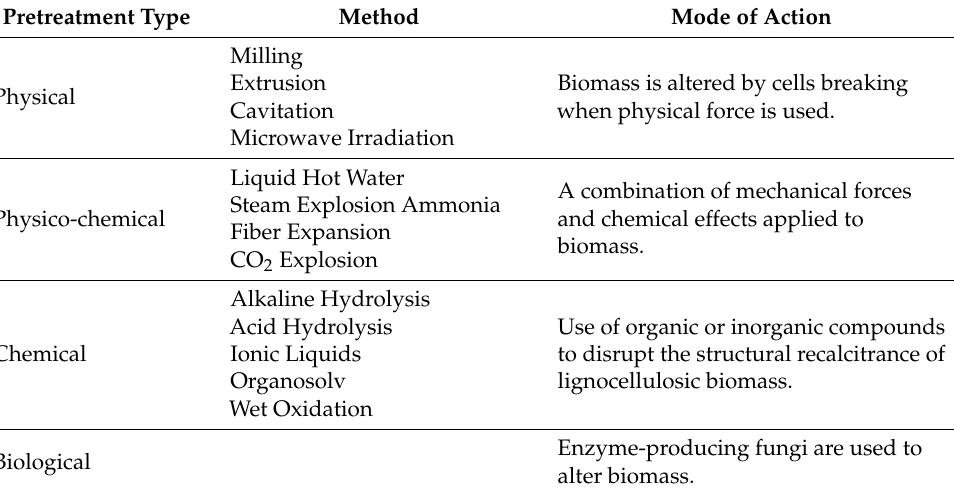
Table 3. Types of pretreatments most used to improve biogas production